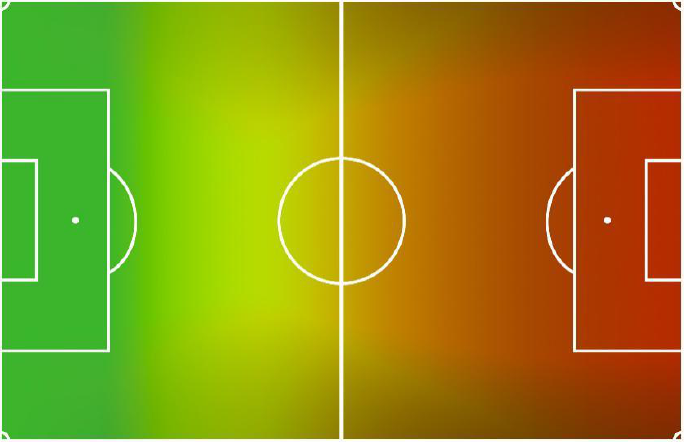
Figure 2. Field zoning plan.